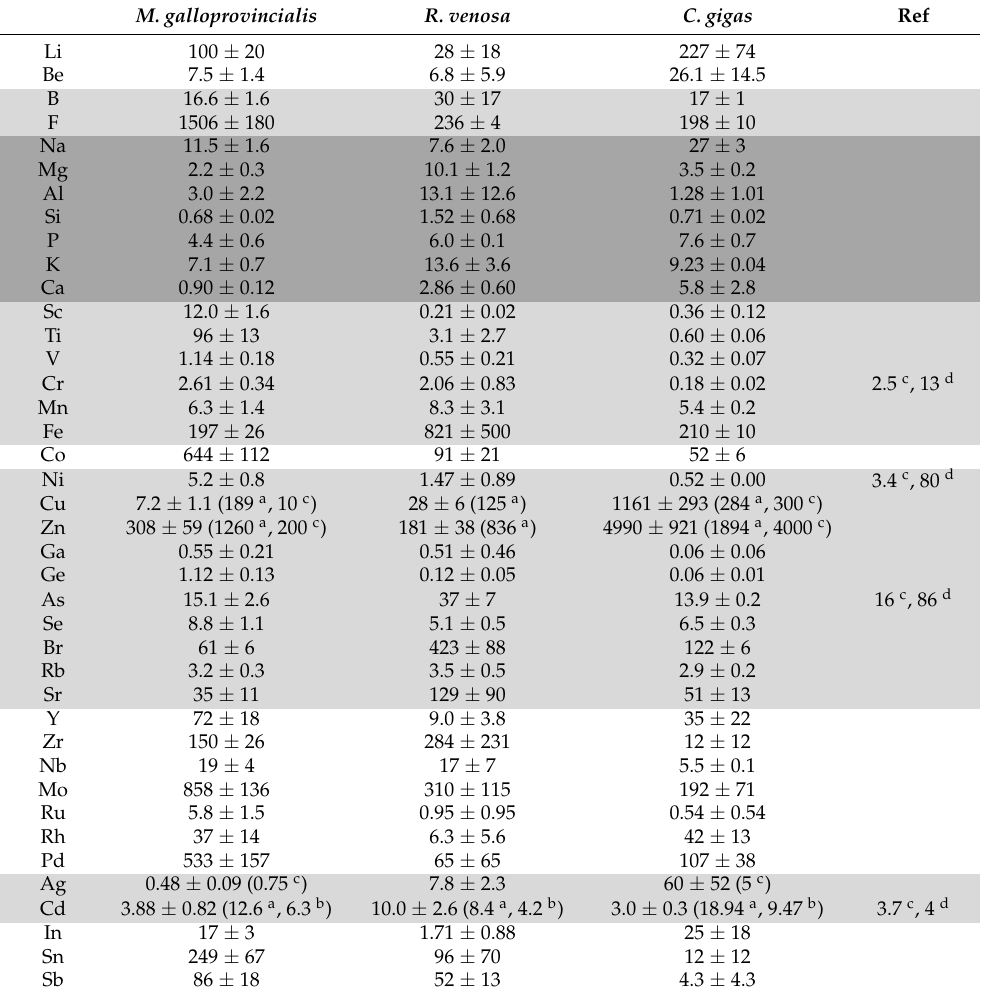
Table 3. Trace element contents in soft tissues of three mollusk species harvested in the mussel-and- oyster farm area near Sevastopol (northwestern Black Sea). Dark shading: in g · kg − 1 , light shading: in in mg · kg − 1 , no shading: in µ g · kg − 1 d.w. In parentheses are the maximum permissible levels [56,57] and/or contamination-indicative concentrations (CIC) [58] for each species. Ref: reference contents (CIC and action levels [59], AL) for mussels and oysters (CIC) or all types of edible mollusks (AL). MPI: metal pollution index [63]. AUI: accumulation universality index. M.